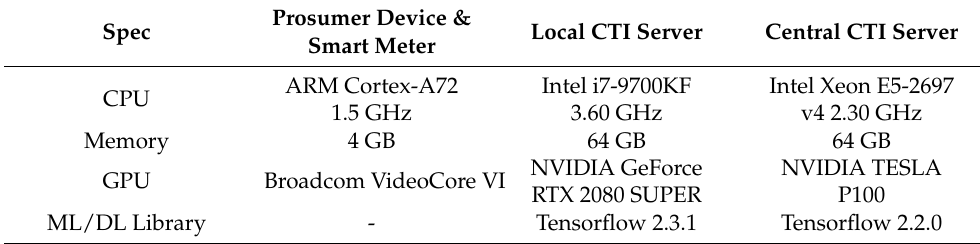
Table 2. Information on devices, servers, and libraries used in the